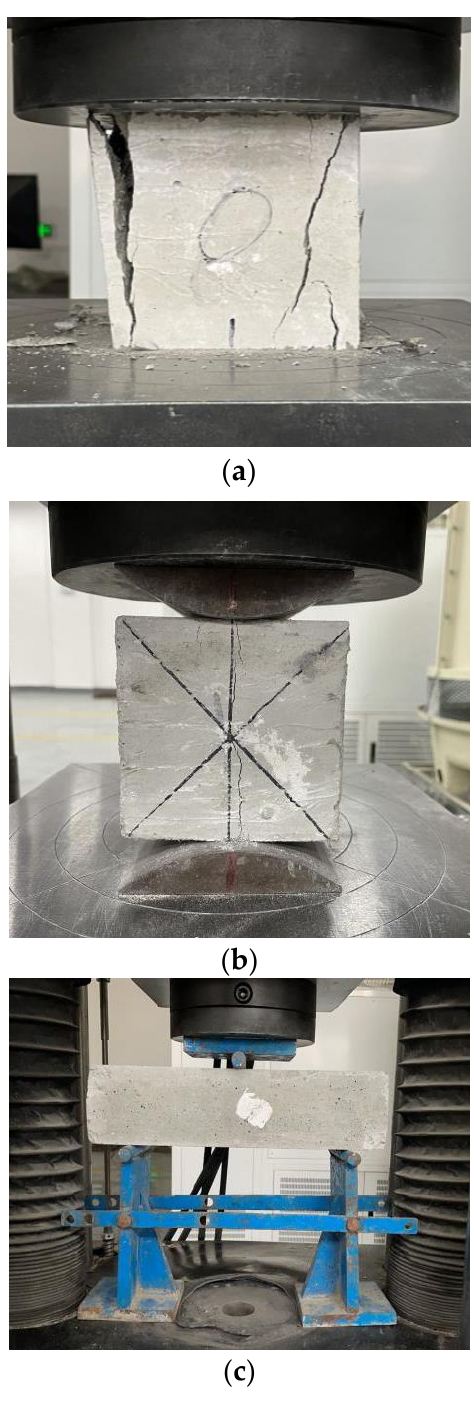
Figure 4. Strength tests. ( a ) compressive strength test; ( b ) splitting tensile strength test; ( c ) flexural strength test. Table 8. The test parameters of strength tests.